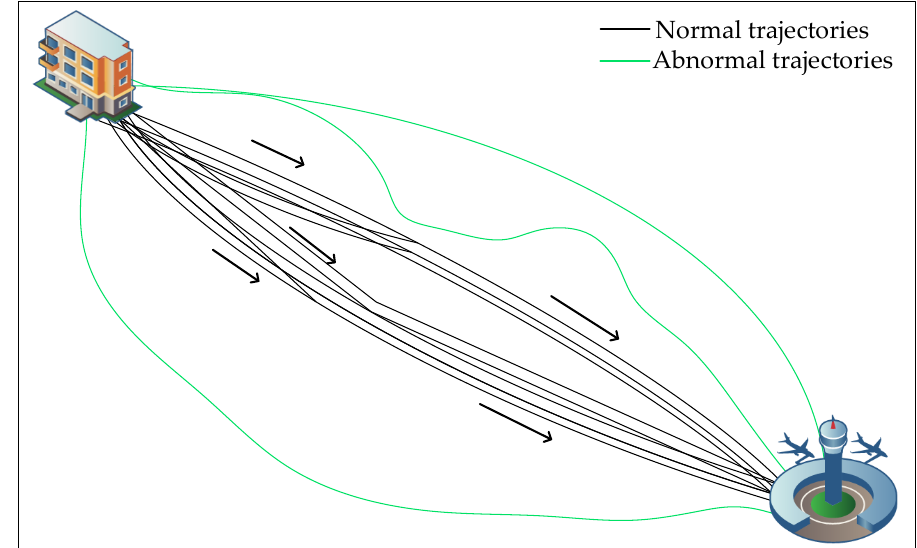
Figure 1. Abnormal and normal trajectories.